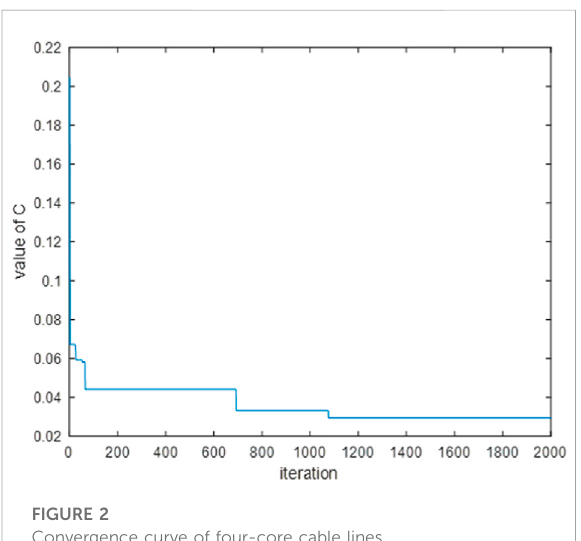
FIGURE 2 Convergence curve of four-core cable lines.